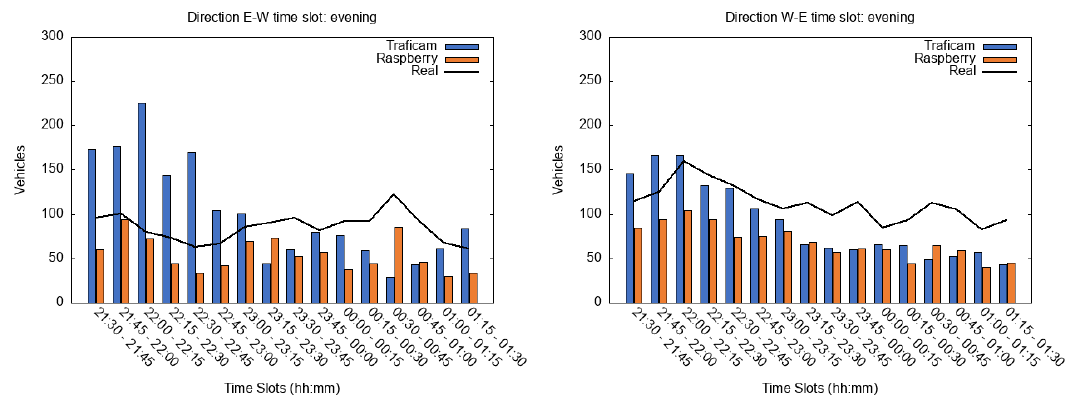
Figure 11. Comparison of Traficam (in blue) and Edge device (in orange) for vehicle counting during the evening time slot. On left part of the figure the direction E-W is shown, on the right part the direction is